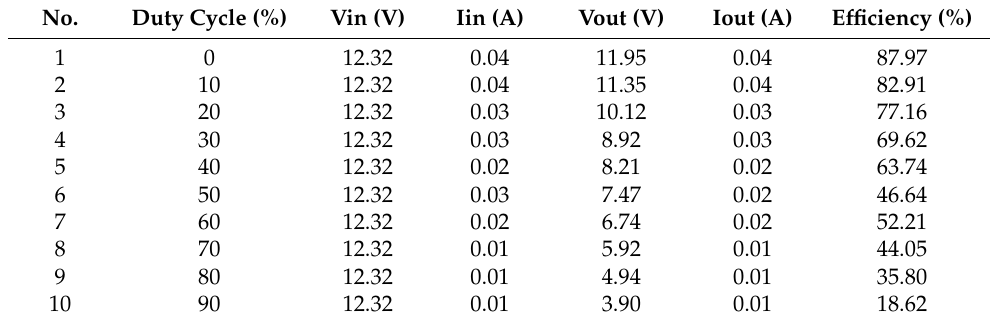
Table 5. Test result buck mode.